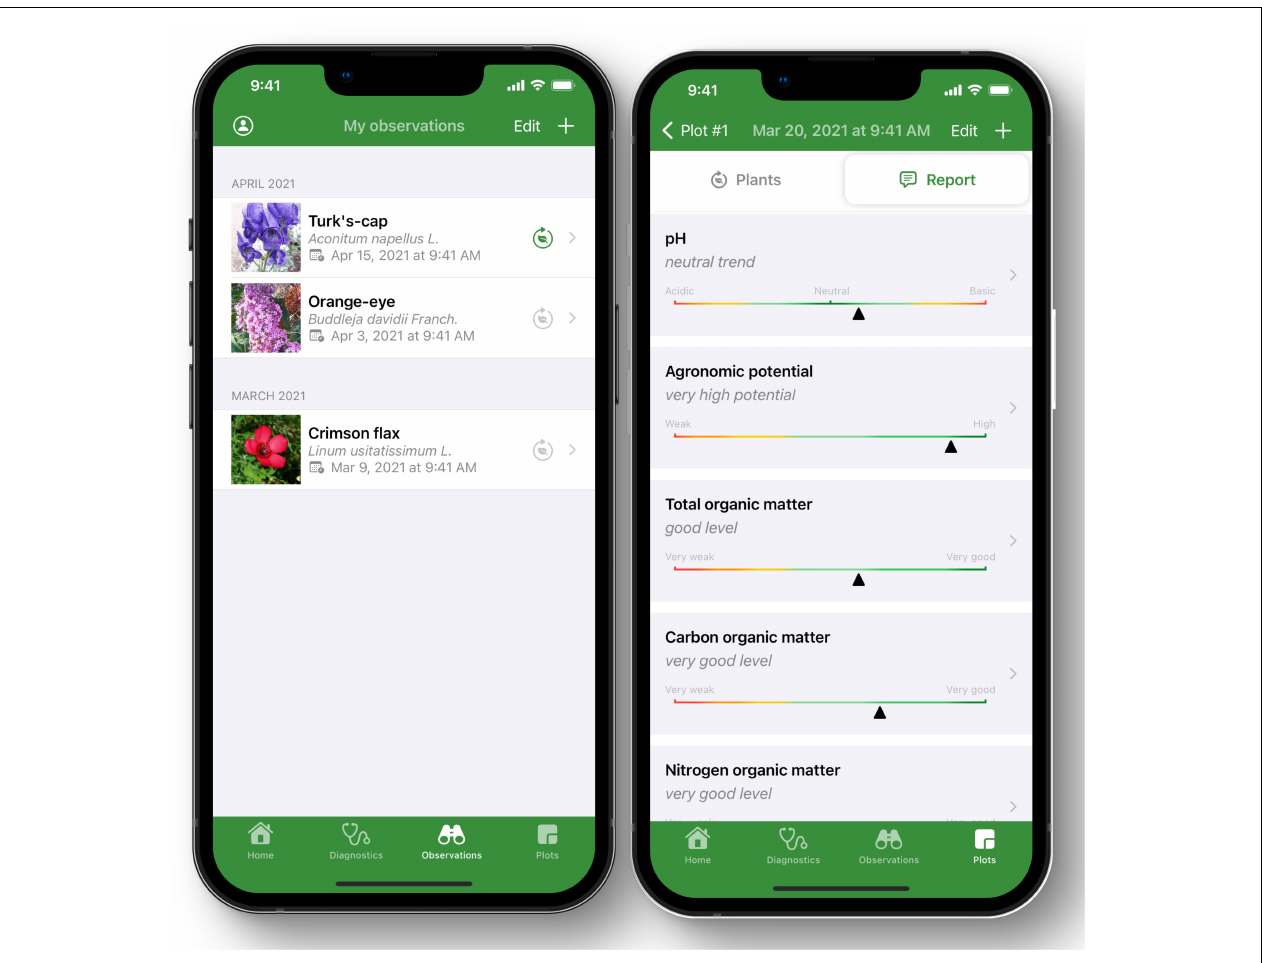
FIGURE 2 | Output from the AGRODIAG mobile artificial intelligence (IA) app showing for instance total organic matter, agronomic potential, pH to give soil assessment for taking measures. Photo Credit: Ver de Terre Digital.